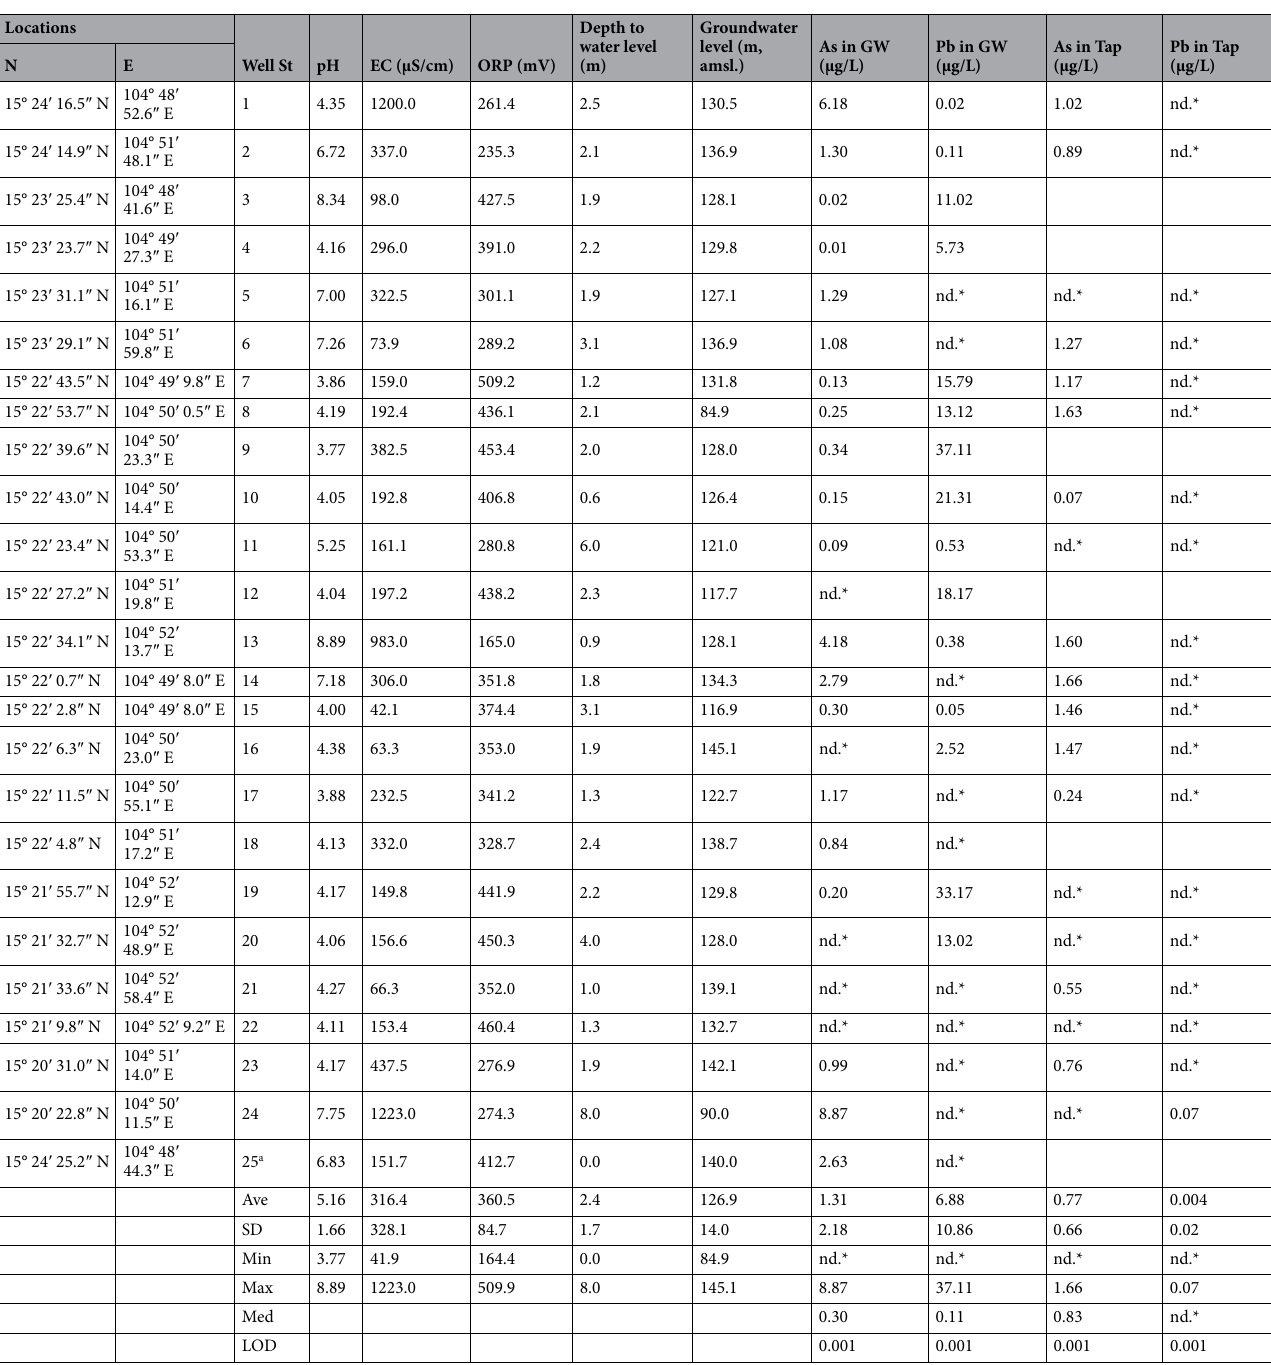
Table 1. Characteristics of the water samples. *nd: no detection or lower than the limit of detection. **Station had no tap water. LOD limit of detection. a Station no.25 is surface water at